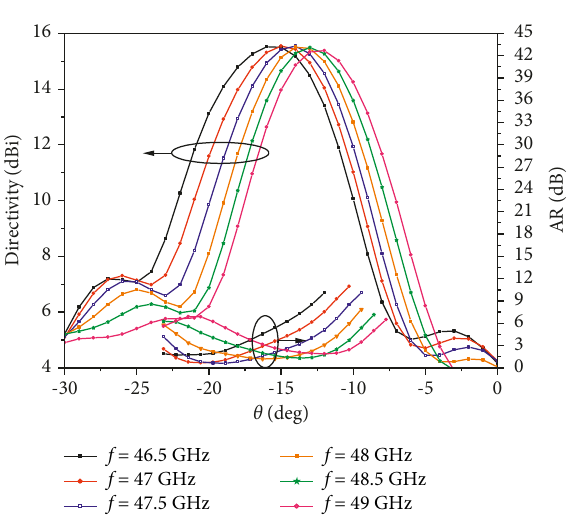
Figure 5: Simulated results of the directivity and axial ratios in the xz -plane for different frequencies. Table 2: Comparison of simulated CP